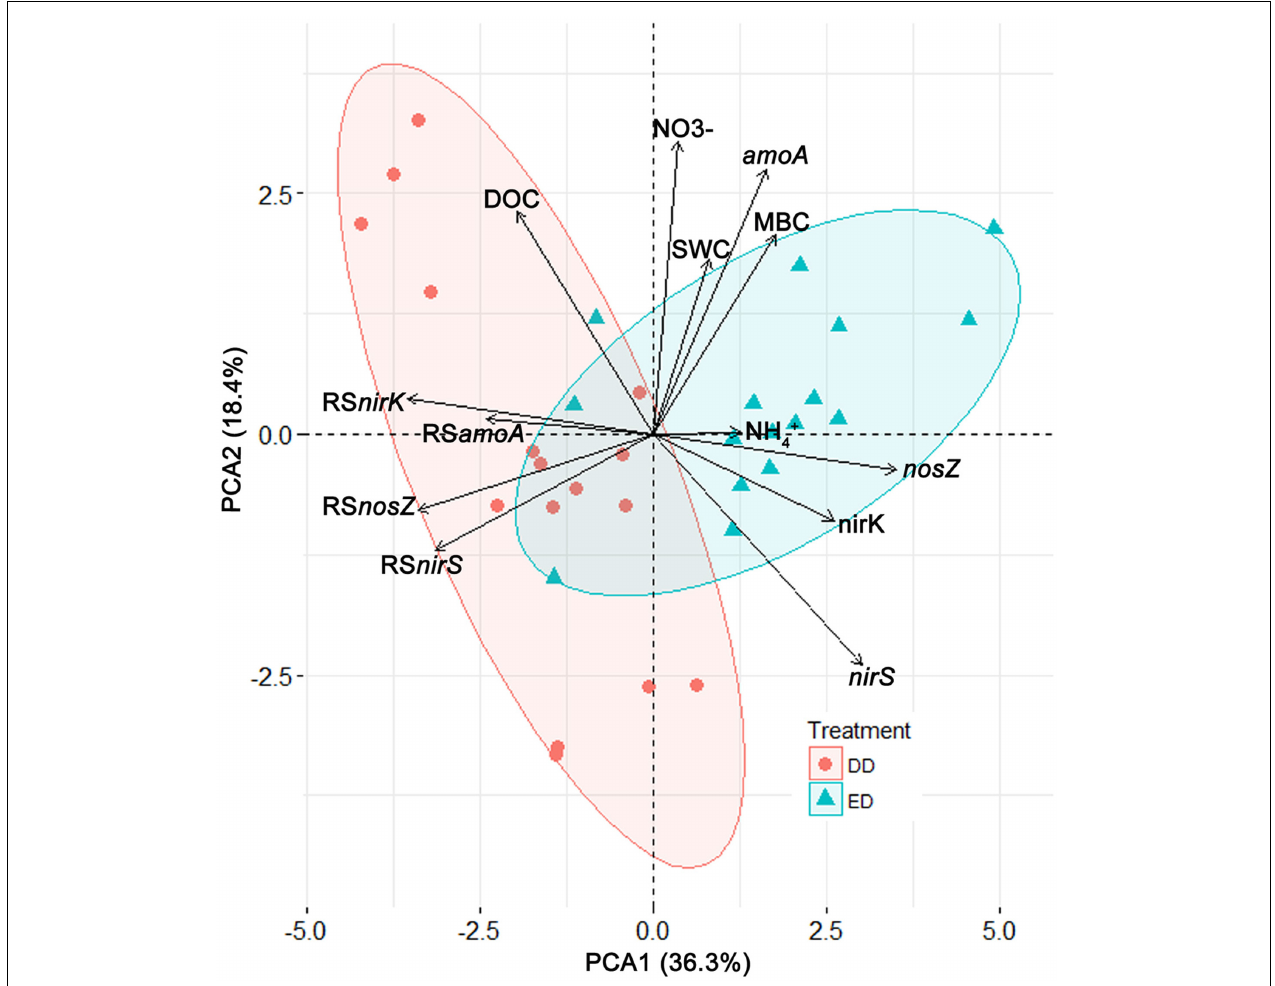
FIGURE 3 | The biplot of the principal component analysis results represented by the first two principle components (PC1 and PC2). Deviation ellipses were drawn to show the distribution of the points from the different treatments. Vectors display the variables contributing to the two principle components. Abbreviations: SWC, soil water content; MBC, microbial biomass carbon; DOC, dissolved organic carbon; RS amoA , RS nirK , RS nirS , RS nosZ , resistance indices of the abundances of the amoA , nirK , nirS , nosZ gene,